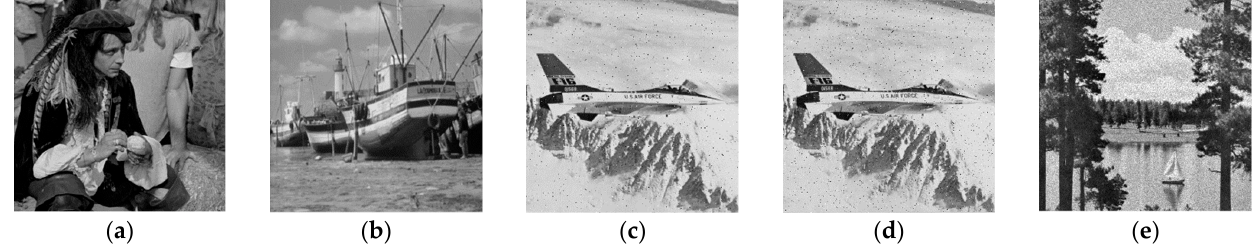
Figure 9. Watermarked images with common noise attacks ( a ) Gaussian filter (5 × 5) var = 1.5, ( b ) average filter (3 × 3), ( c ) salt and pepper noise (var = 0.01), ( d ) salt and pepper noise (var = 0.02), ( e ) speckle noise (var = 0.02). Table 5. Robustness against various types of noise attacks in terms of BCR (%).